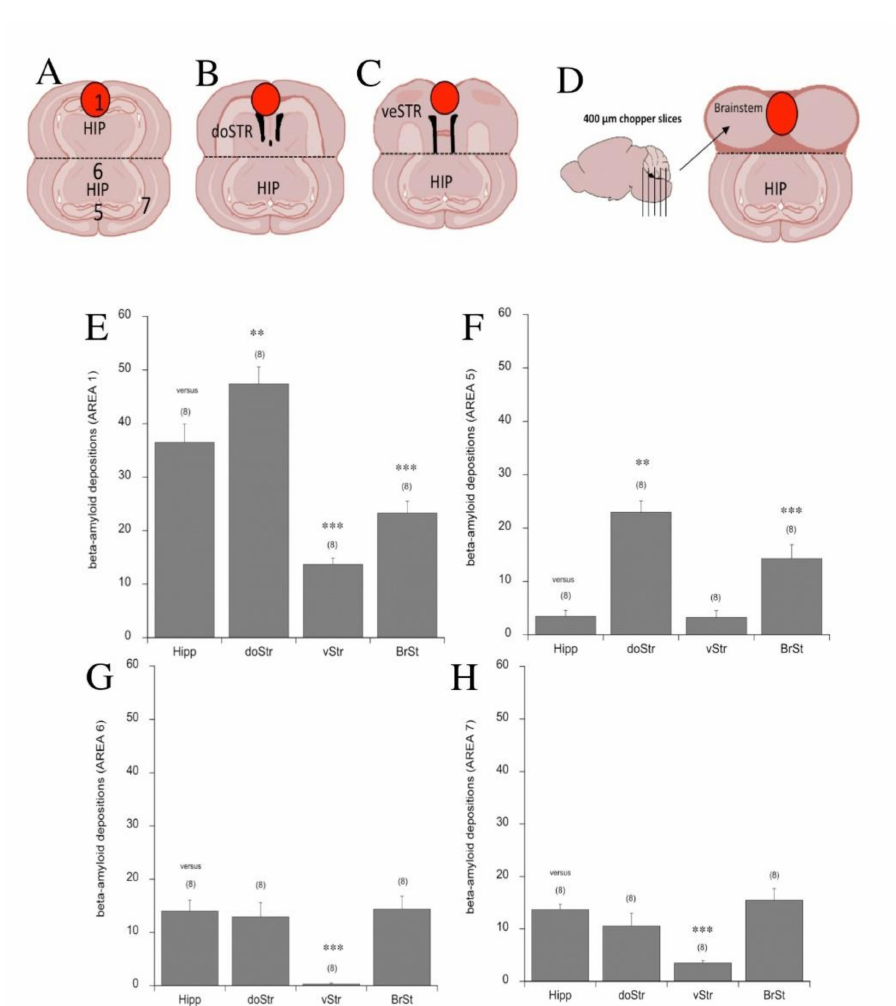
Figure 7. Beta-amyloid spreading in different brain areas . The hippocampal (HIP) target brain slice was connected to the hippocampal (HIP) slice ( A ), to the dorsal striatum (doSTR) slice ( B ), the ventral striatal (veSTR) slice containing limbic areas and the amygdala and piriform cortex ( C ) and the brainstem ( D ). As it was difficult to prepare coronal slices of brain stem, we prepared 400 µ m-thick chopper slices from brain stem and connected two to three such slices to the target hippocampal slice ( D ). Quantifications of beta-amyloid depositions were performed in area 1 ( A , E ), area 5 ( A , F ), area 6 ( A , G ) and area 7 ( A , H ). Values are given as means ± SEM; values in parenthesis give the number of animals. Statistical analysis was performed by one-way ANOVA with a subsequent Fisher LSD post hoc test compared to the hippocampal target slices (** p < 0.01; *** p <